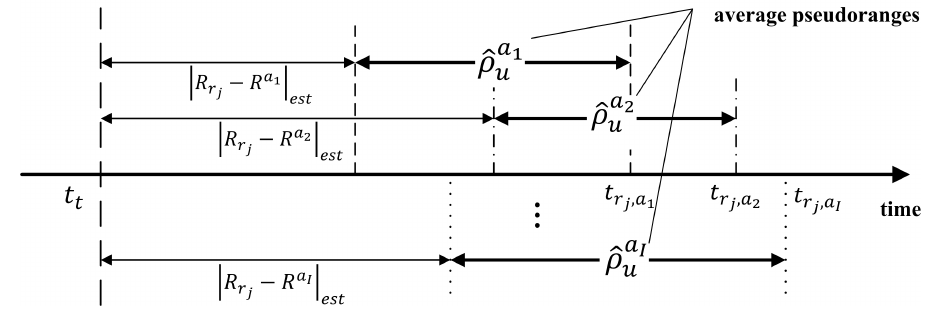
Figure 4. Estimation of pseudoranges between the airborne relays and